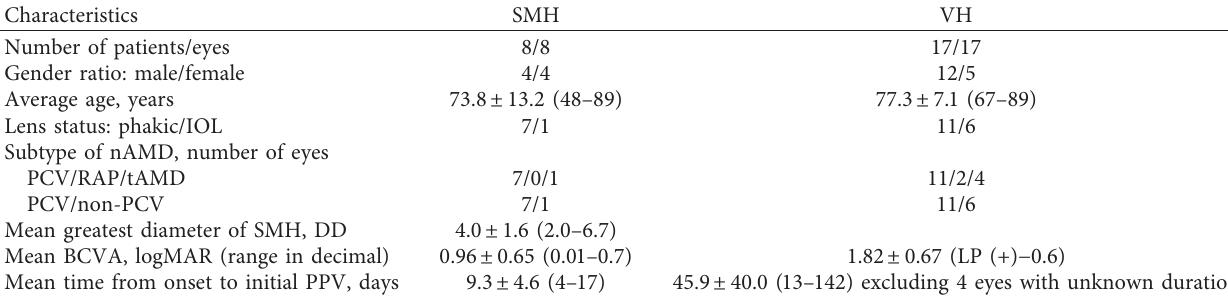
Table 1: Baseline characteristics of the patients.